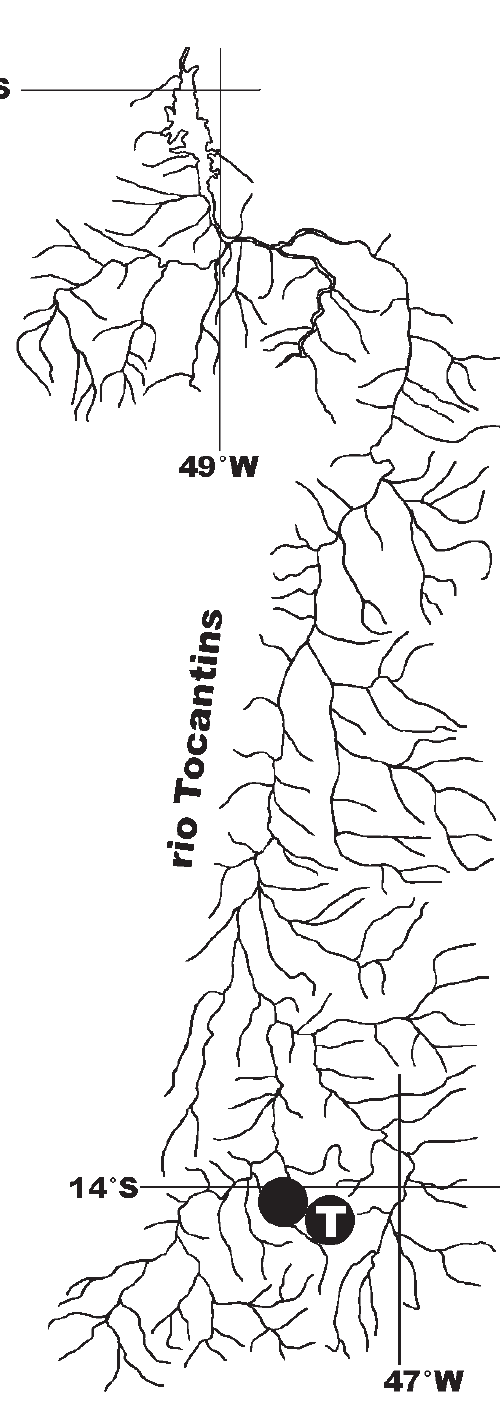
Fig. 11. Geographic distribution of Gymnotocinclus anosteos in the upper rio Tocantins drainage. Circles represent collect- ing sites, and T is the